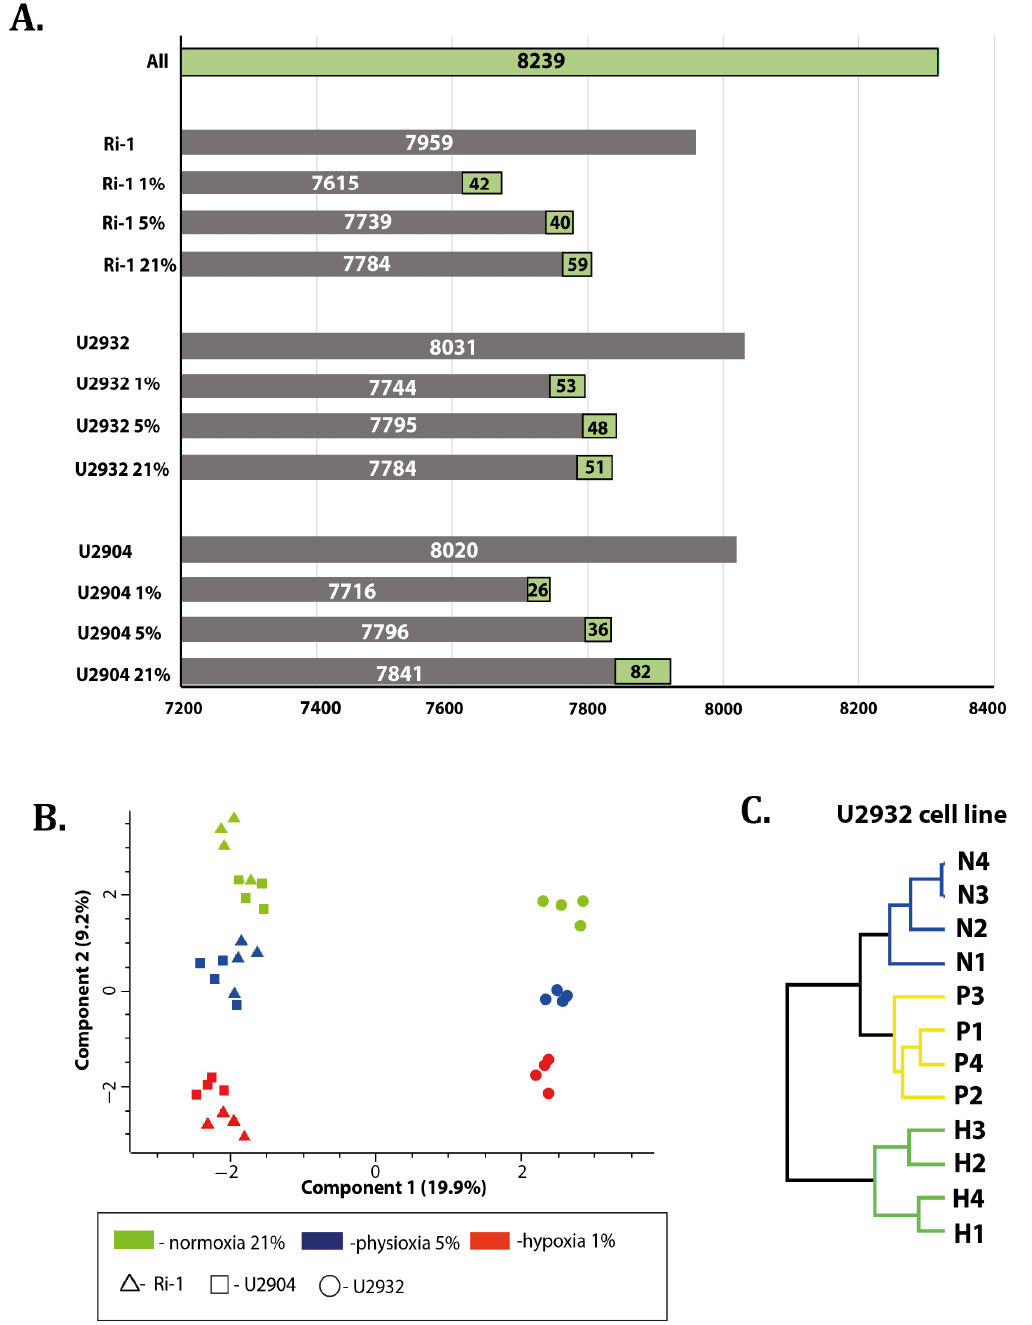
Figure 1. Exploratory analysis. ( A ) The number of proteins identified in the study in each experimental group. The green boxes indicate the number of proteins identified exclusively in the corresponding experimental group. ( B ) Results of principal component analysis (PCA) of log2 intensities values from Ri-1, U2904, and U2932 cell lines (in four biological replicates) under normoxia (21%) physioxia (5%), and hypoxia (1%). ( C ) Dendrogram that displays unsupervised hierarchical clustering analysis between U2932 samples under hypoxia (H, 1% of O 2 ), physioxia (P, 5% of O 2 ), and normoxia (21% of O 2 ). Performed in Perseus